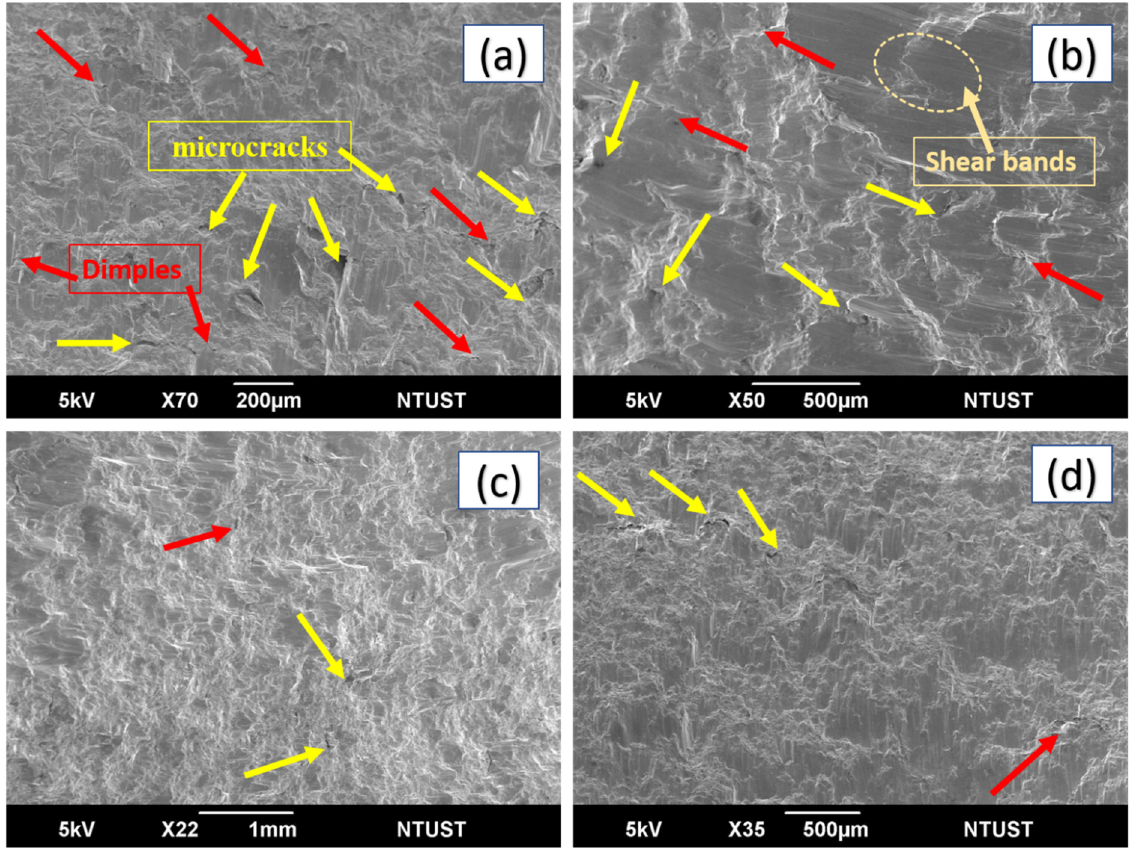
Figure 14. Fractography of the compression-ruptured surfaces of ( a ) pure AZ91 matrix, ( b ) AZ91 + 0.5 wt.% SiCp, ( c ) AZ91 + 1 wt.% SiCp and ( d ) AZ91 + 0.5 wt.% SiCp + 1 wt.% Bi + 0.4 wt.% Sb.